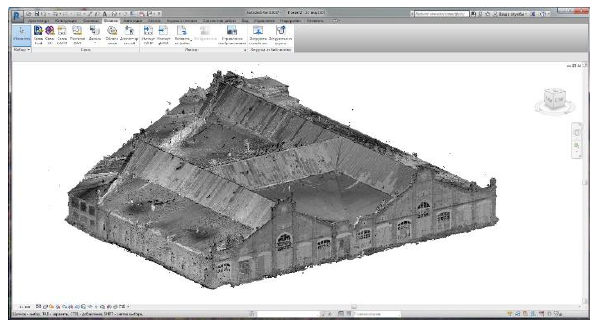
Figure 3. Point 3D model of building in Revit